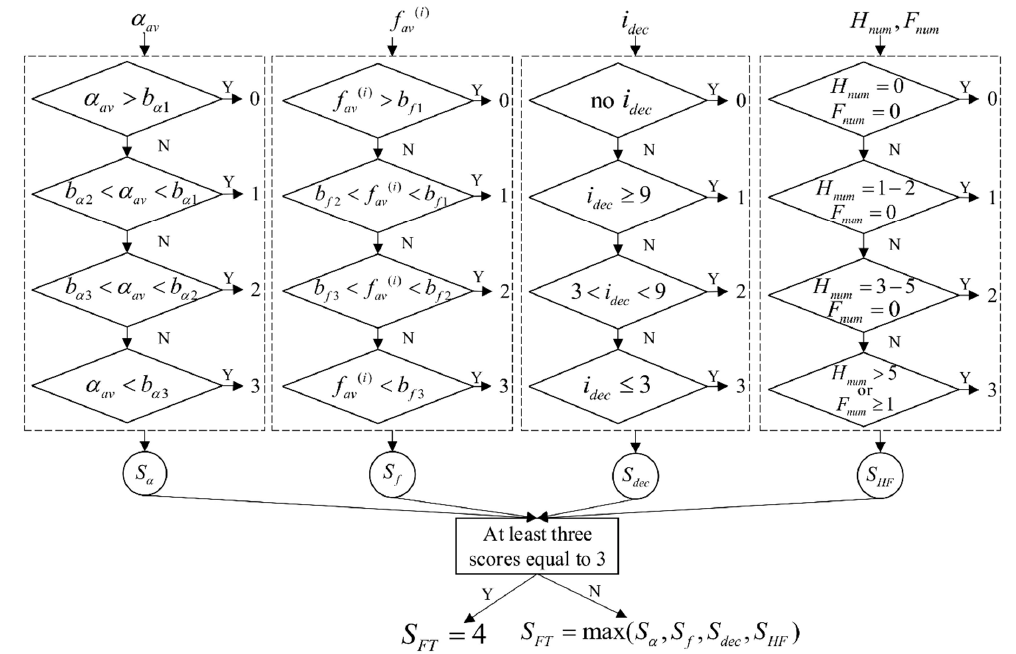
Figure 7. The block scheme of the decision support system. The system is divided into four processing blocks (bordered with dashed black rectangles). The inputs to the blocks are the calculated features: α av , f av i dec , and H num , F num , respectively. Each block implements rules and assigns a subscore for the input feature. The final score S FT is decided based on the results obtained from all four blocks.